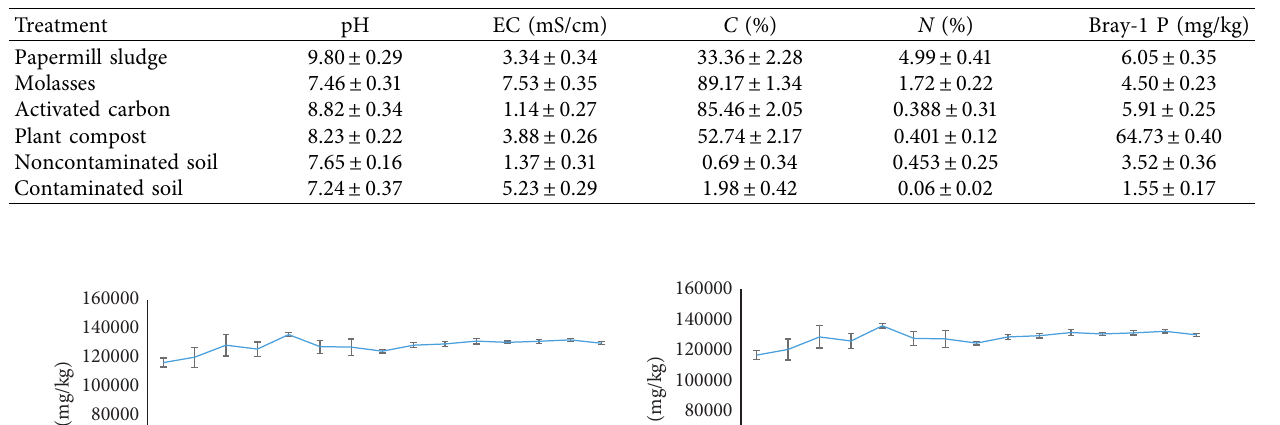
Table 2: Selected chemical characteristics of soil and amendments, mesocosm study.